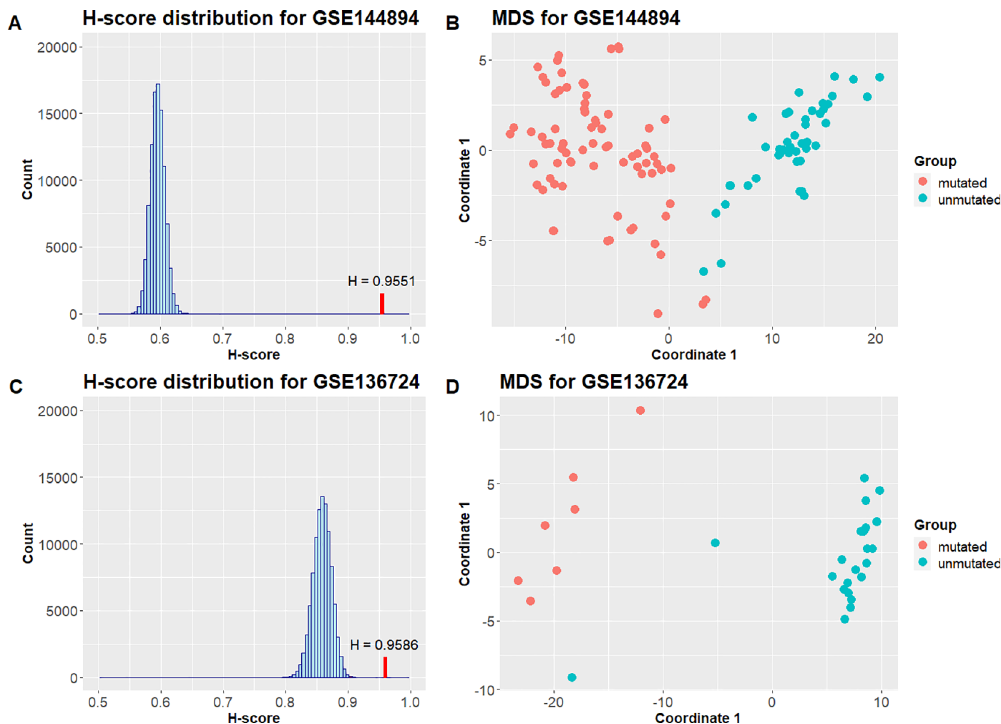
Figure 5. A: H-score distribution for GSE144894 dataset (blue) and H-score corresponding to the validated signature (red) B: MDS plot for GSE144894 samples based on the differential methylation signature C: H-score distribution for GSE136724 dataset (blue) and H-score corresponding to the validated signature (red) B: MDS plot for GSE136724 samples from untreated group based on the differential methylation